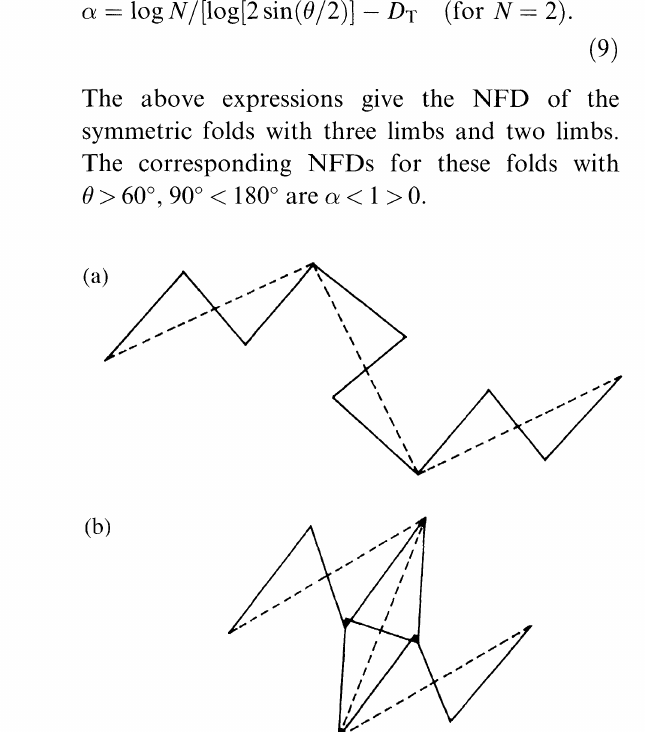
FIGURE 2 Symmetric folds with several folds of different IAs are shown schematically. (a) Schematic of self-avoiding symlnetric fold profile with second order folds. The IA of first order fold (shown in dotted line) is greater than 60 and (b) a schematic of self-intersecting symmetric fold profile with sec- ond order folds. The IA of first order fold (shown as dotted line) is lesser than critical angle, i.e., 60 Hence, it is self- intersecting. The intersecting second order folds may be